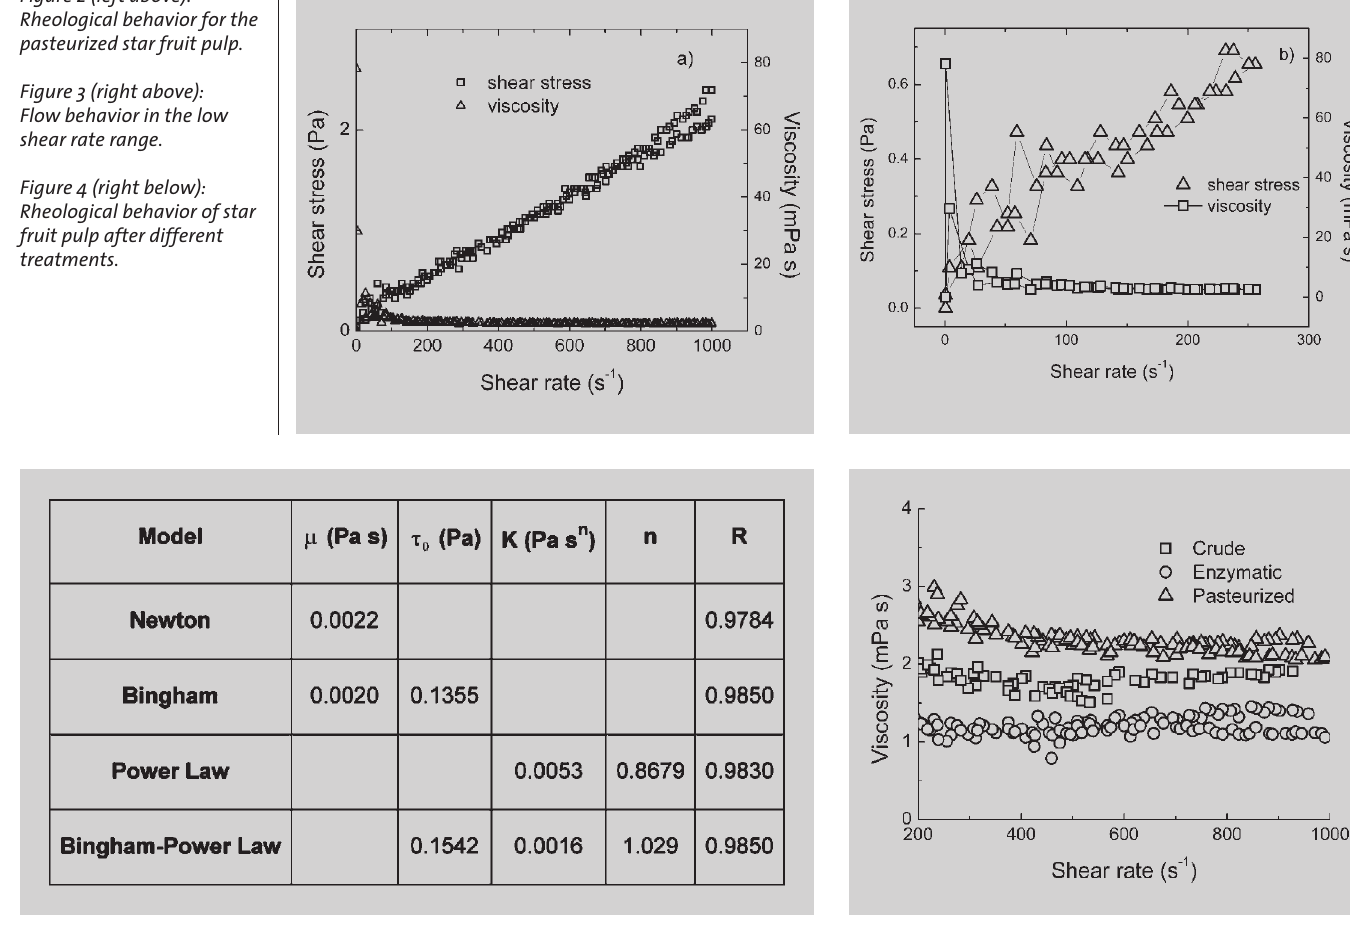
Table 1: Model mean parameters fitted to pasteurized